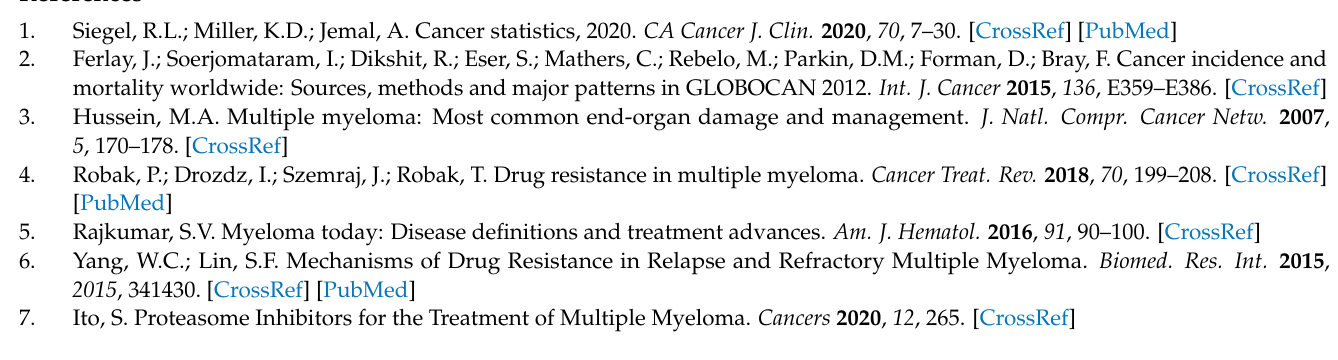
S4: Target-binding affinities of Ibrutinib. Figure S5: Relative viability of U266 cells after 24 h treatment with WA or DEX. Figure S6: Relative BTK mRNA and protein levels of MM1R cells treated with IBR. Figure S7: Relative viability of MM1R cells treated with increasing concentrations of WA for 15 min. Figure S8: Relative BTK mRNA and protein expression of siBTK-transfected MM1R cells with or without the C481S BTK mutant. Figure S9: The biological targets of WA treatment strongly depends on cellular context. Table S1: Summary of the binding energy of the covalent bond of Cys481 with WA as predicted by covalent docking. Table S2: Overview of qPCR primers used in this study. Table S3: Overview of siRNA sequences used in this study. Table S3: Overview of siRNA sequences used in this study. Table S4: Original images western